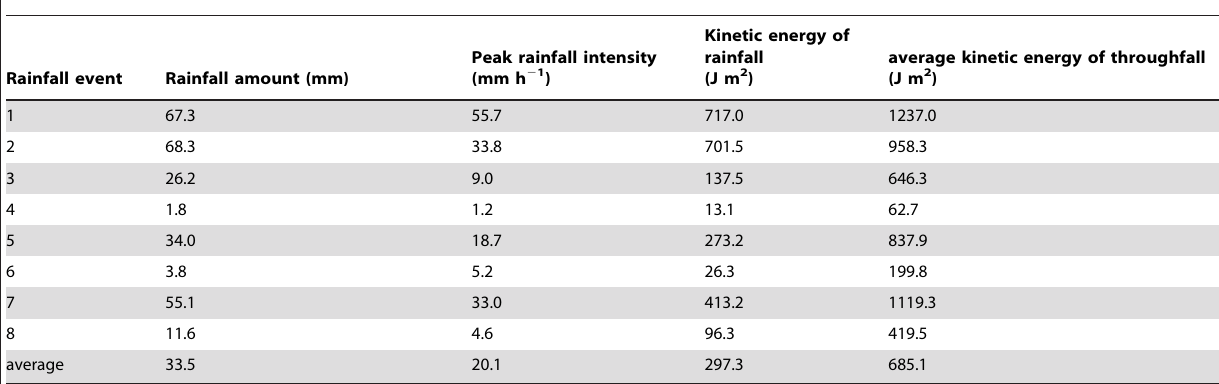
Table 1. Characteristics of the rainfall events measured.